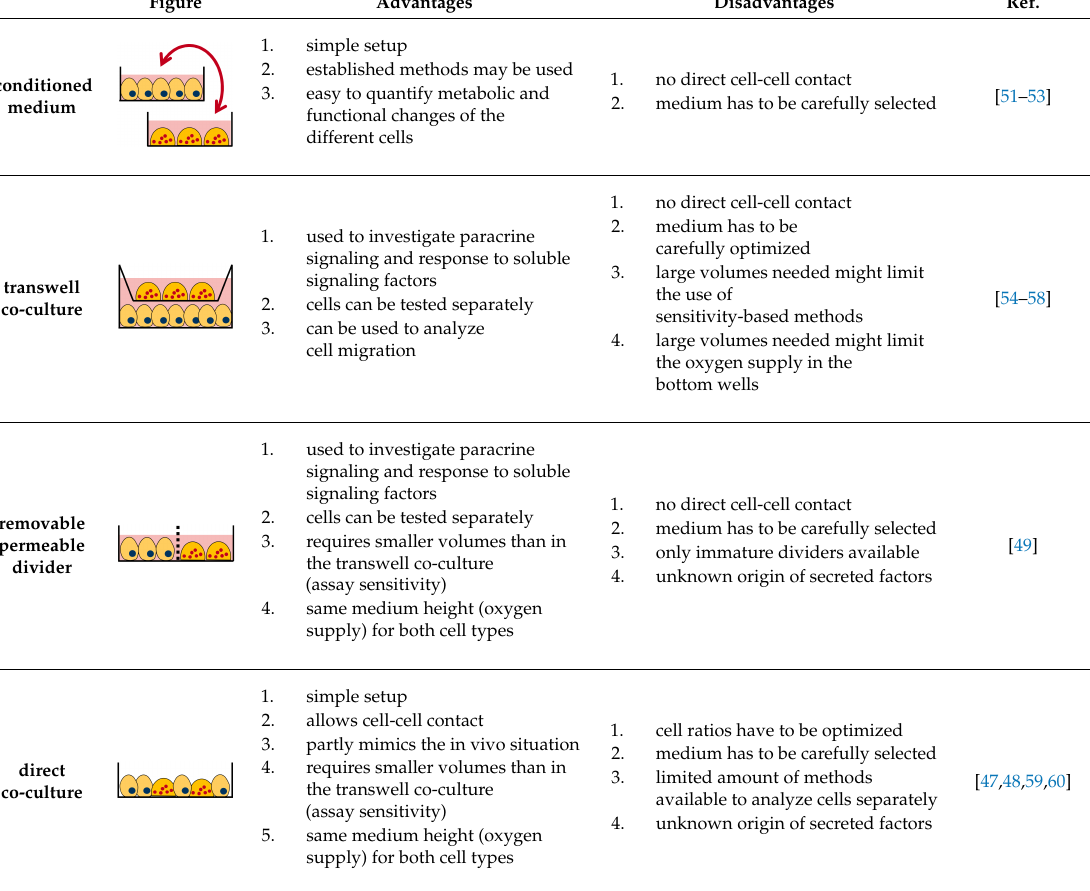
Table 1. Co-culture models in 2D.